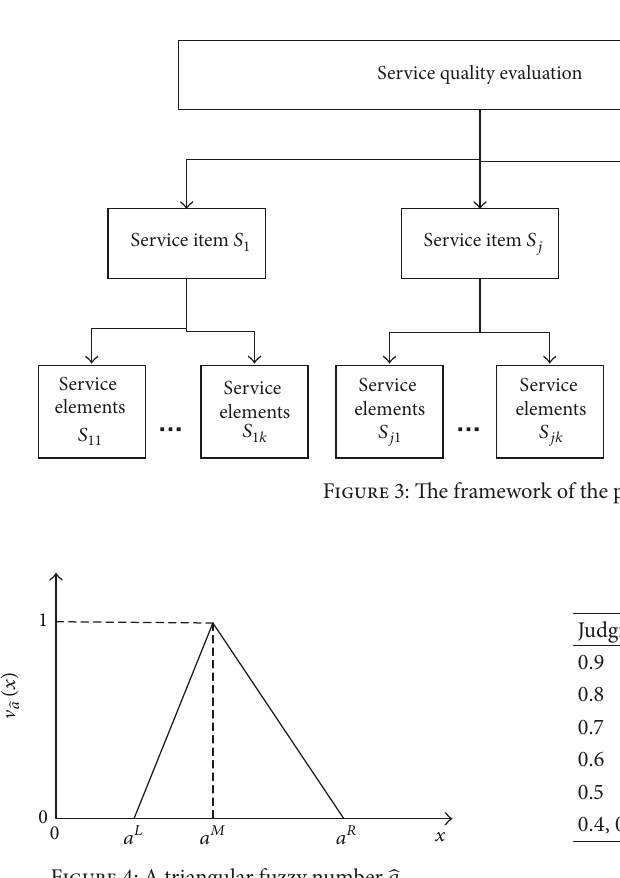
Figure 4: A triangular fuzzy number ̂𝑎 .